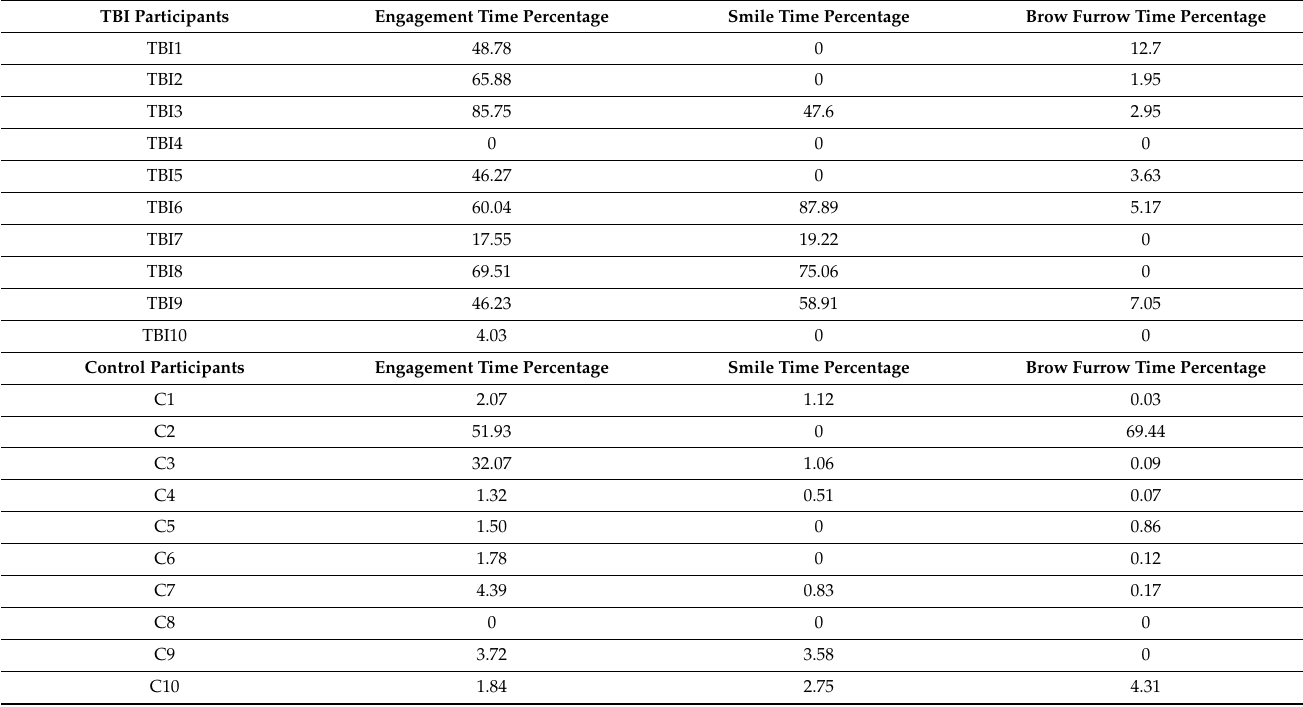
Table 4. Results generated by Affectiva of TBI participants and control participants on personal event narrative.